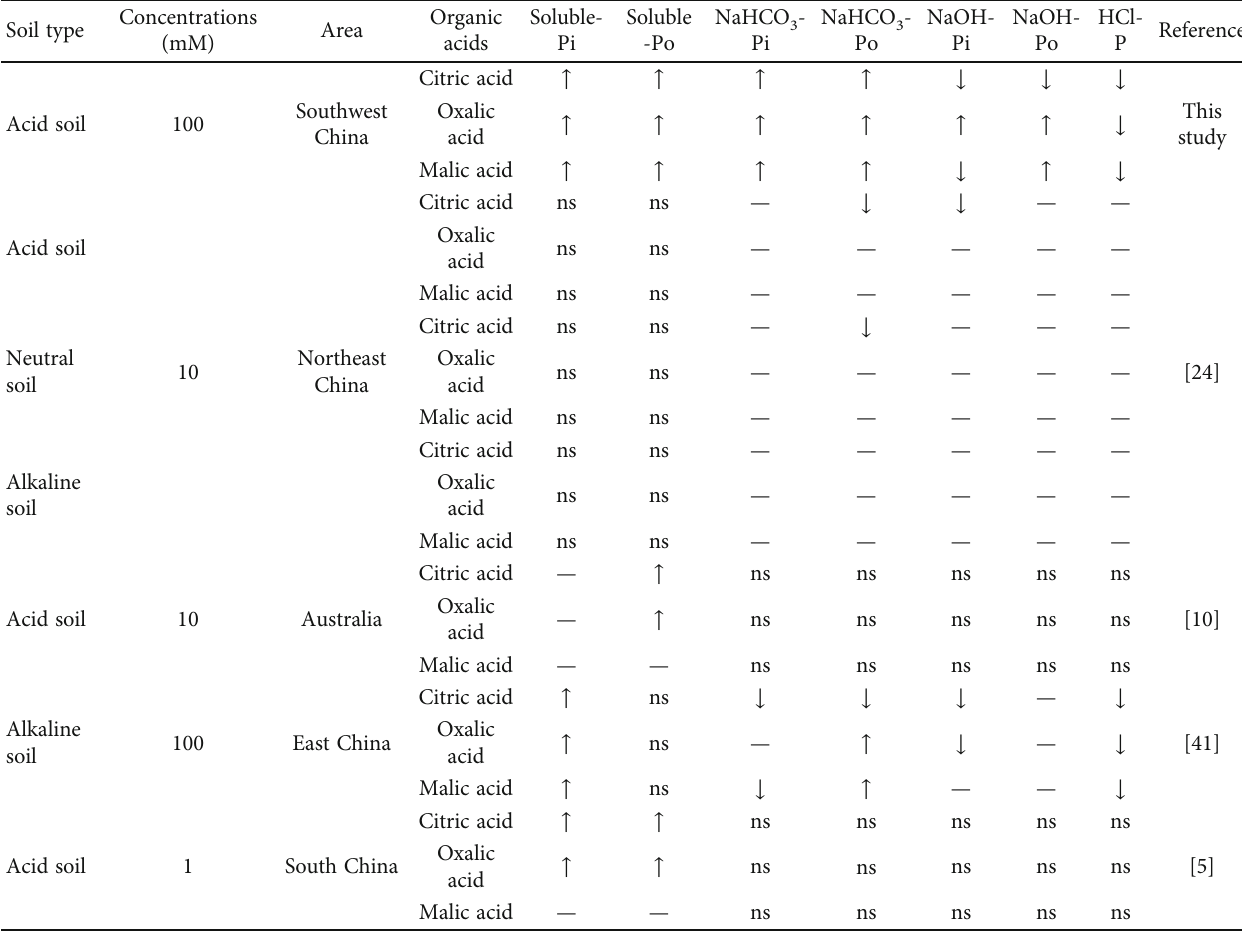
Table 1: The variations of P fractions induced by organic acids compared with other